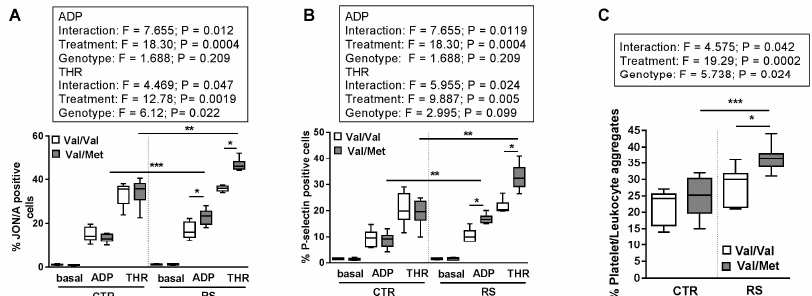
Figure 4. Effect of restraint stress on platelet activation in BDNF Val/Val and BDNF Val/Met mice. Flow cytometry analyses of: ( A ) GPIIbIIIa activation (JON/A-PE antibody); ( B ) P-selectin expression in washed platelets at basal condition or after exposure to ADP (5 µM) or thrombin (THR 0.05 U/mL); and percentage of ( C ) platelet/leukocytes in whole blood isolated from stressed (RS) and not stressed (CTR) BDNF Val/Val and BDNF Val/Met mice. n = 6 mice/group. Two-way ANOVA followed by Bonferroni post hoc analysis, p values were obtained by using log-transformed variables. * p < 0.05, ** p < 0.01 and *** p < 0.005. For each box-plot, the center line illustrates the median and box limits indicate the 25th and 75th percentiles.